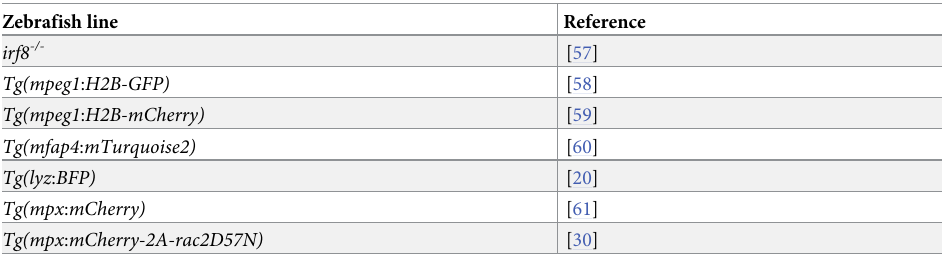
Table 1. Zebrafish lines used in this